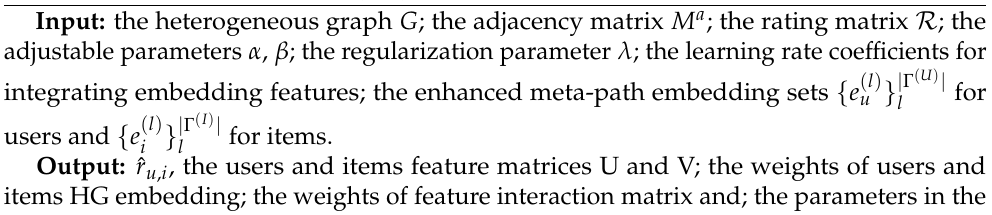
Algorithm 2: HGE-CRec training